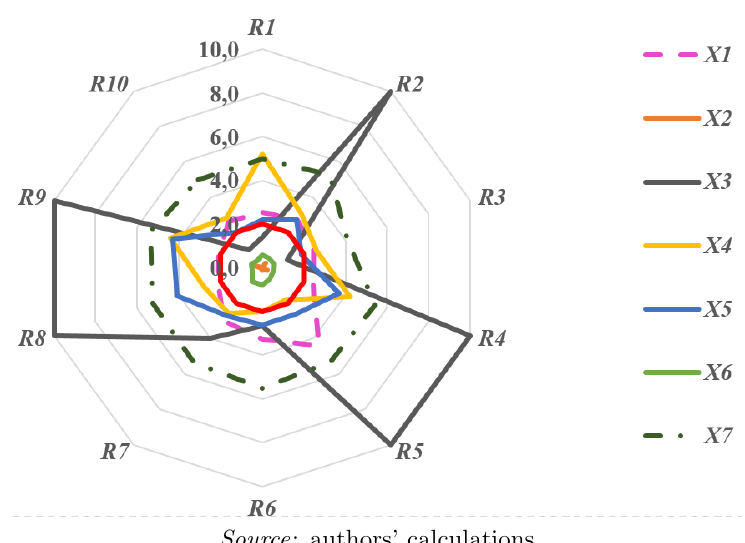
Figure 2: Polygon of economic security of the regions of